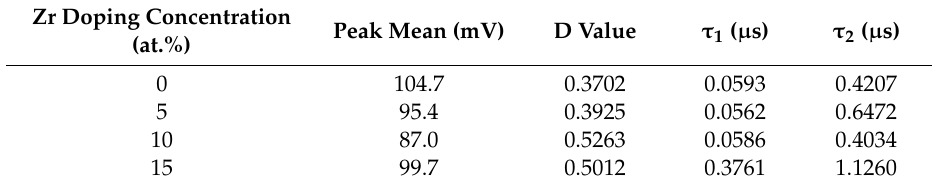
Table 3. Properties of In 2 O 3 thin film with different doping concentrations of zirconium tested by μ -PCD. Zr Doping Concentration (at.%)